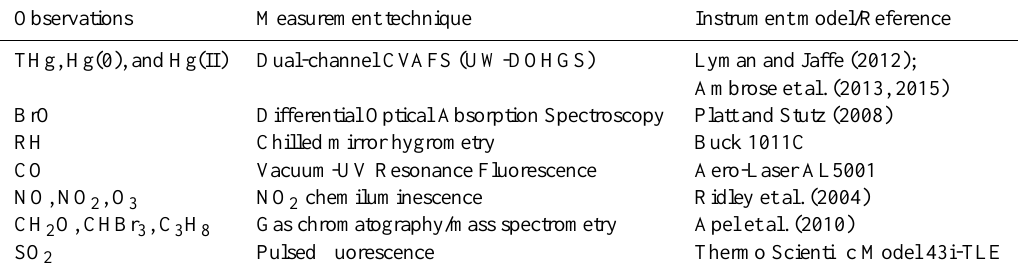
Thermo Scientific Model